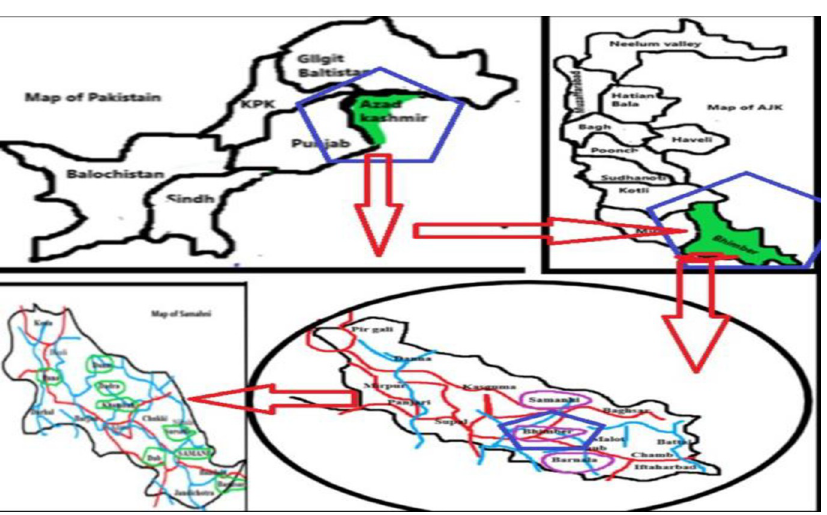
Fig 1. Map of study of Shiwalik mountaineous range of District Bhimber of Azad Jammu and Kashmir, Pakistan.